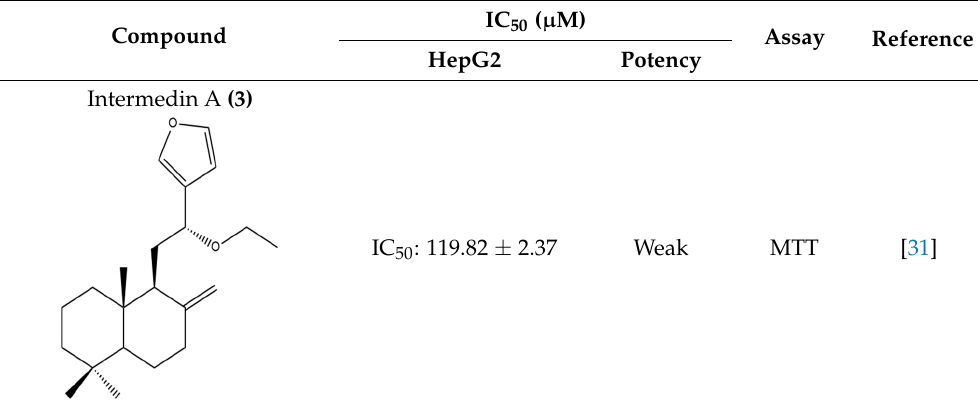
Table 11. Cytotoxic activities of labdane-type diterpenes from the Zingiberaceae against HepG2 liver cancer cell line.